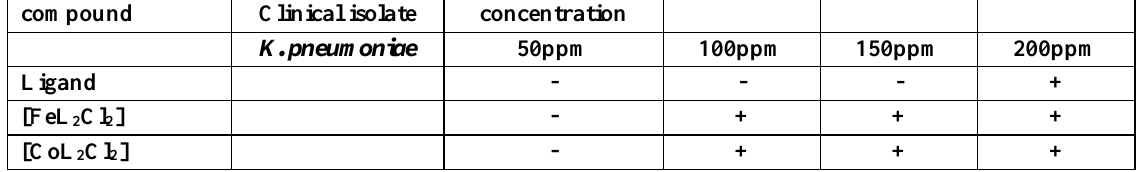
Table 9. Minimum inhibitory concentration ( MIC) of Schiff base ligand and its metal complexes. compound